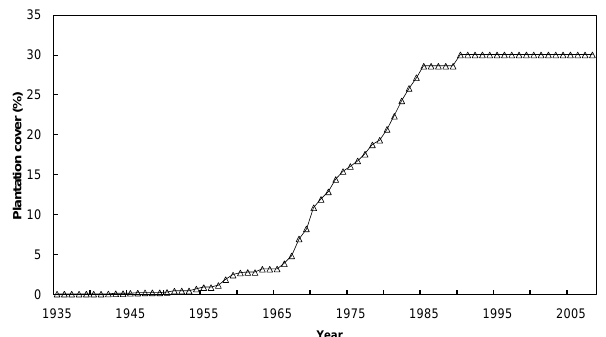
Fig. 4. Cumulative plantation cover (%) over time for the Adjung- Figure 4. Cumulative plantation cover (%) over time for the Adjungbilly Creek catchment. 2 billy Creek